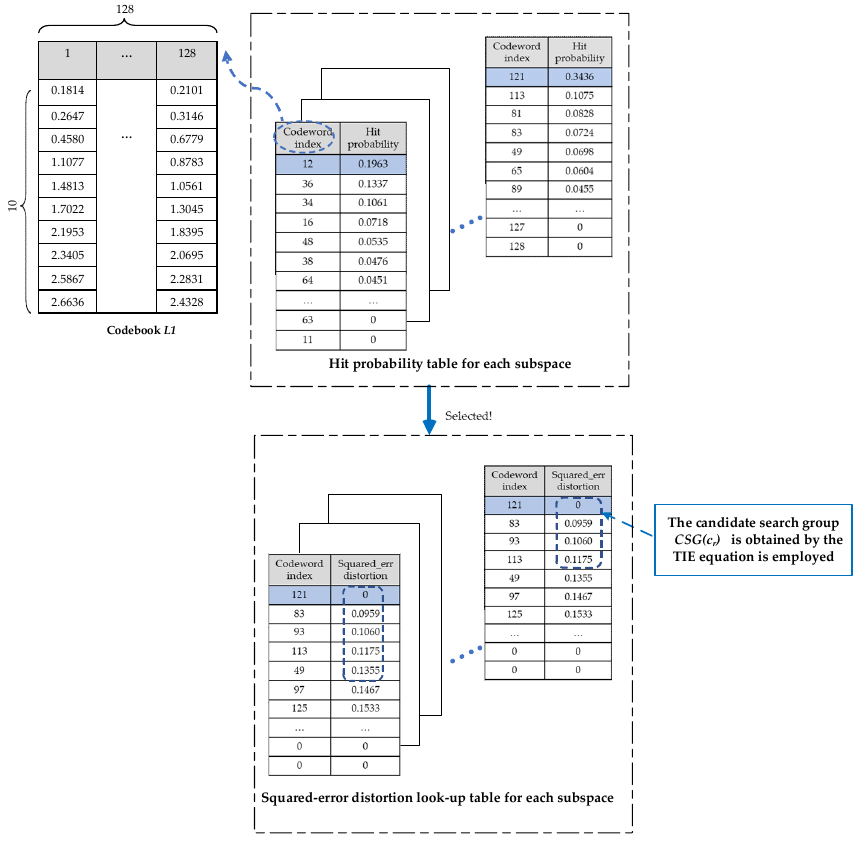
Figure 3. The squared-error distortion look-up table is designed for each subspace.